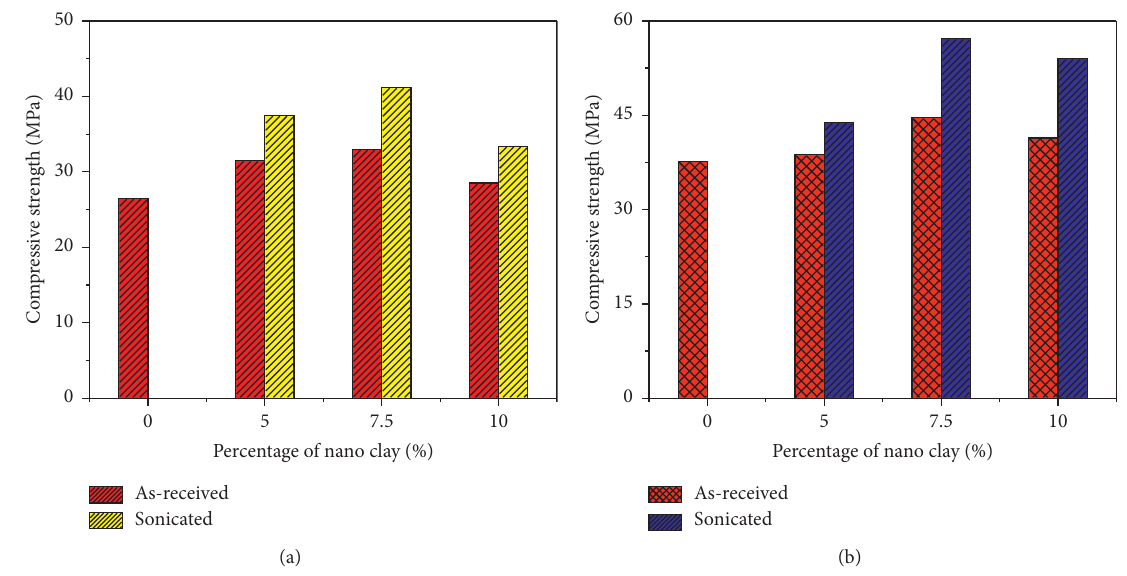
Figure 26: Compressive strength of concrete treated with as-received and sonicated NC after (a) 7 days standard curing and (b) 28 days standard curing